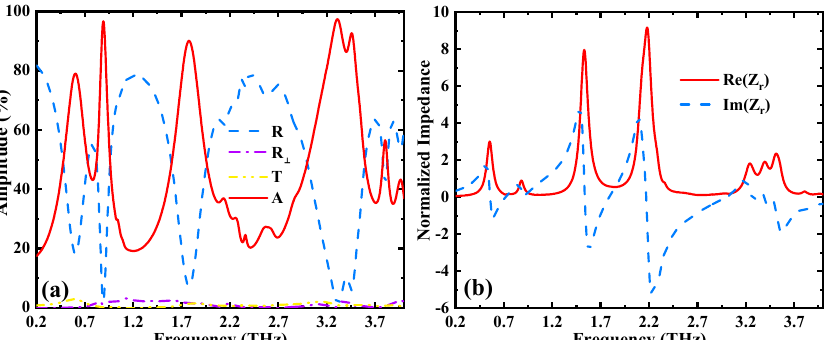
= 3 × 10 5 S/m and = 3 × 10 5 S/m 2 (cid:3118)